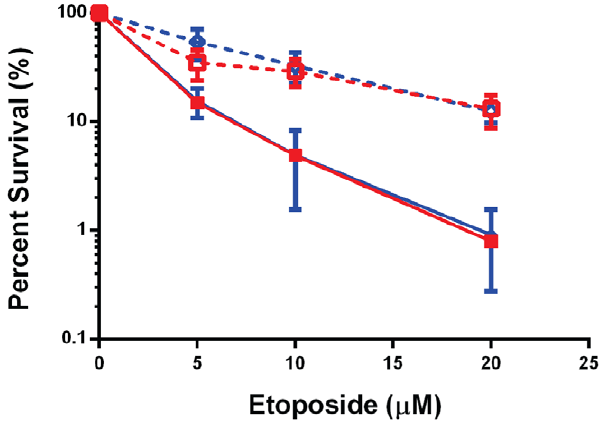
Figure 2. Ire1 does not contribute to increased resistance to etoposide in response to ER stress. Clonal survival assays were performed on Ire1 wild-type (blue) and knock-out (red) cells after 6 hrs of pretreatment with (dashed lines) or without (solid lines) thapsigargin follow by 2 hrs with the indicated concentrations of etoposide. The number of colonies formed for each concentration of etoposide is represented as a percent of those formed without etoposide. Data from three independent experiments are shown and the error bars indicate standard deviations.